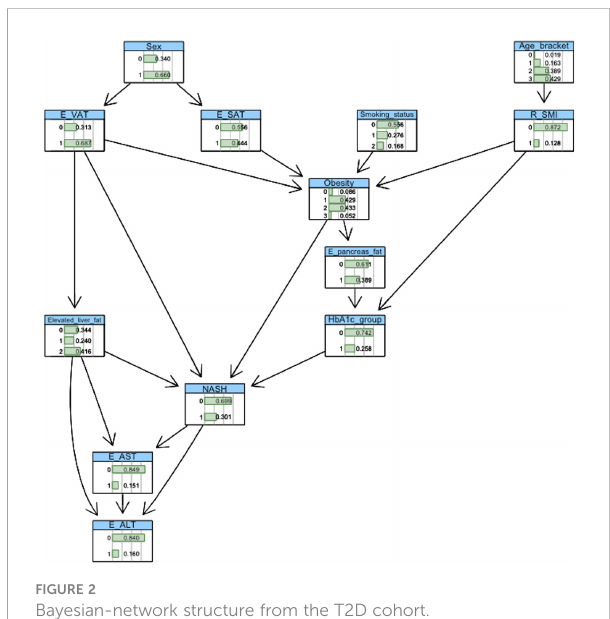
FIGURE 2 Bayesian-network structure from the T2D cohort.